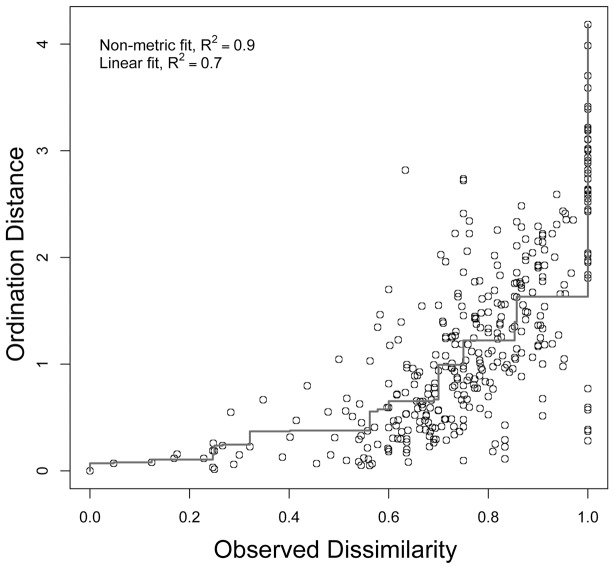
Shepard diagram.Relationship between NMDS ordination distance and original observed distance. NMDS ordination was undertaken on an abundance per species matrix.